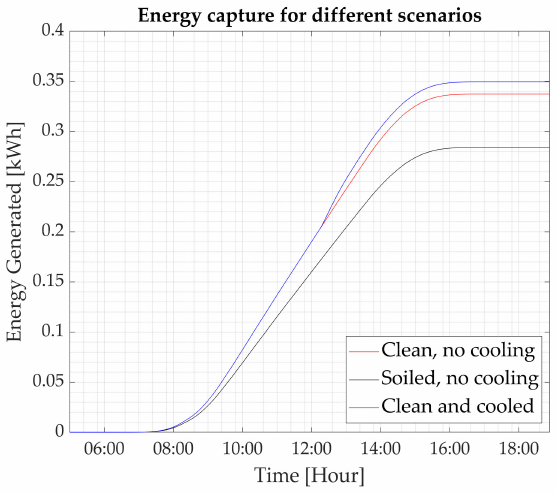
Figure 8. The energy capture of the PV panel under different conditions. Figure 8 indicates the difference in performance from the single PV panel of